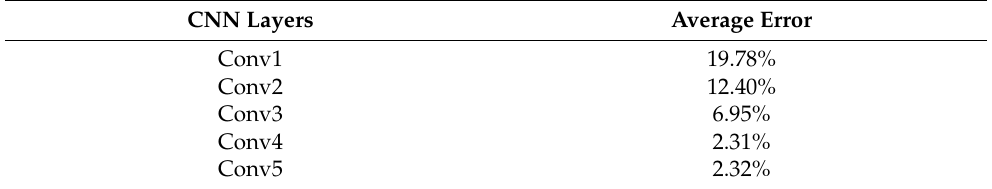
Table 4. Average HR